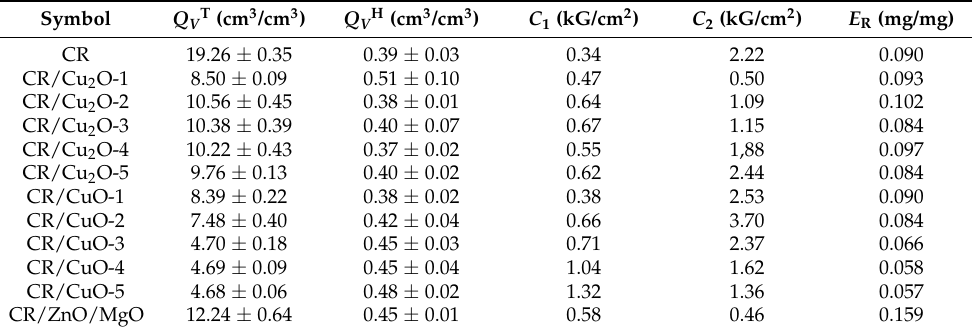
Table 3. Values of equilibrium swelling, elasticity constants, and real extract of CR vulcanizates; T = 160 ◦ C, t = 45